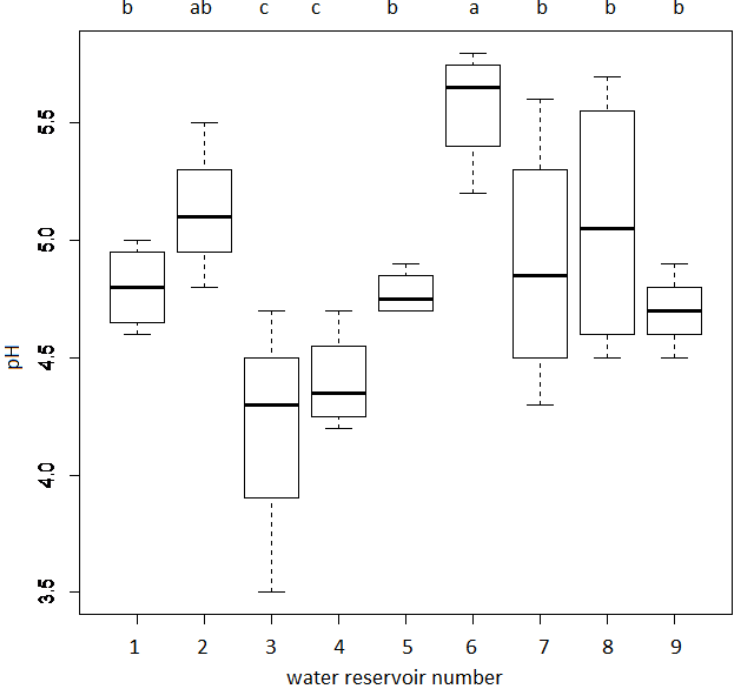
Figure 8. Water reaction in the examined reservoirs (different letters demonstrate significant differ- ences at p < 0.01).